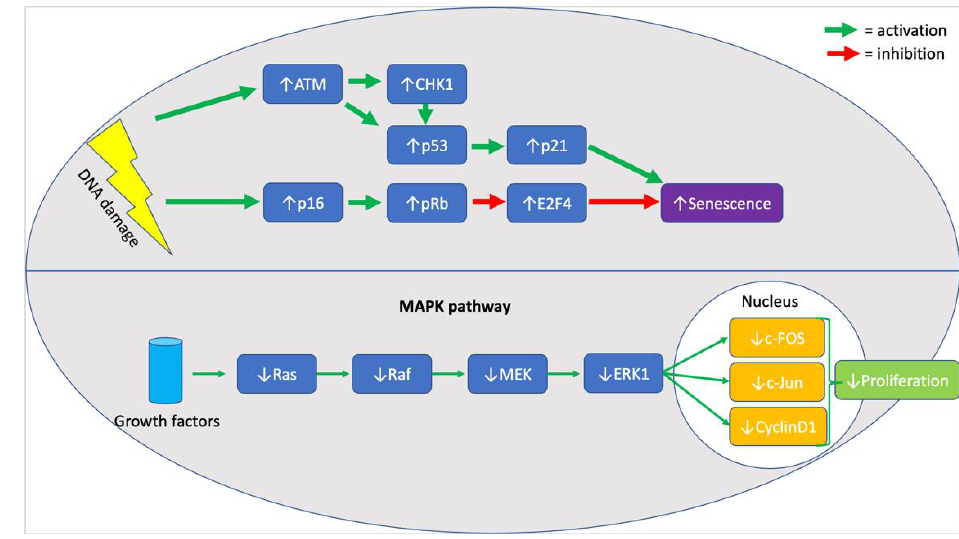
Figure 1. Summary of molecular markers implicated in the senescence phenotype of aged MSCs .